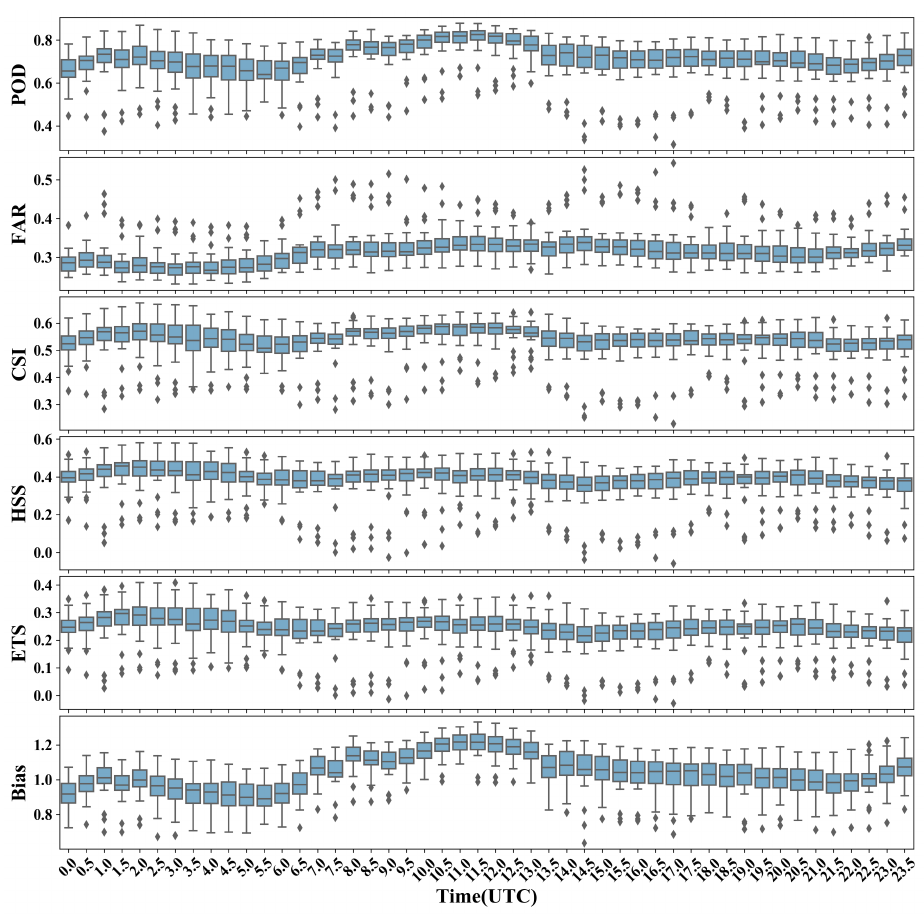
Figure 5. The diurnal variation of the evaluation scores for rain area determination on the testing dataset during August 2018; the distributions of the statistical values by half-an-hour are interpreted in box plots. Box diagrams indicate the 25th, 50th, and 75th percentiles, whereas the periphery of the box extends to 1.5-times the quartile deviation (25th–75th percentile). Outliers are indicated by black dots.